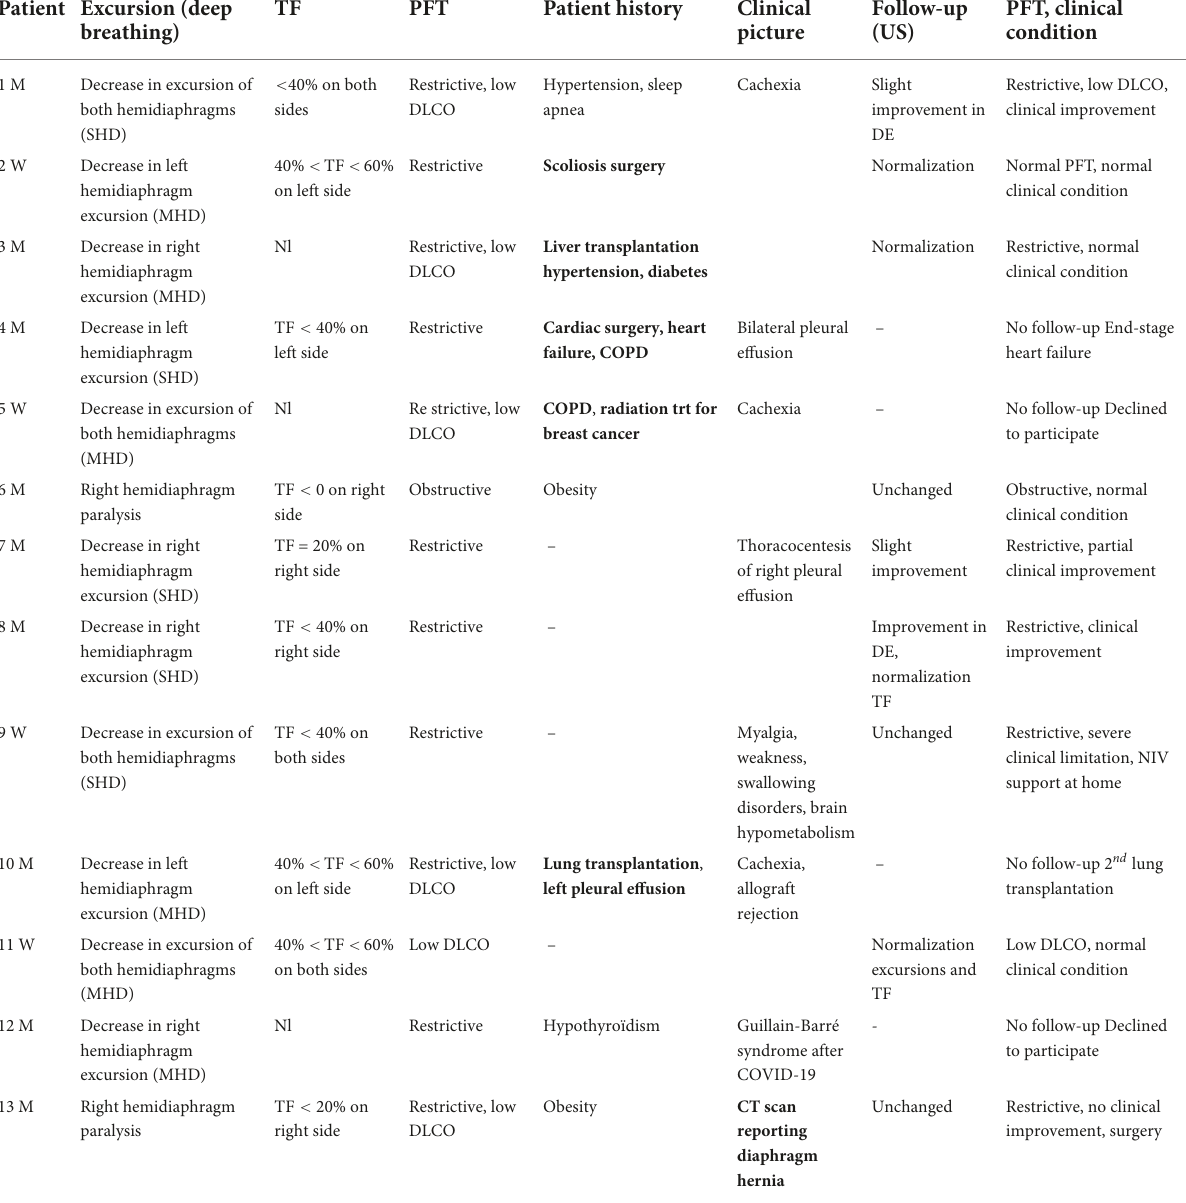
TABLE 2 Patients suffering from diaphragm dysfunction after SARS-CoV-2 infection: Ultrasound examination and pulmonary function testing (PFT). Patient Excursion (deep TF PFT Patient history Clinical breathing)